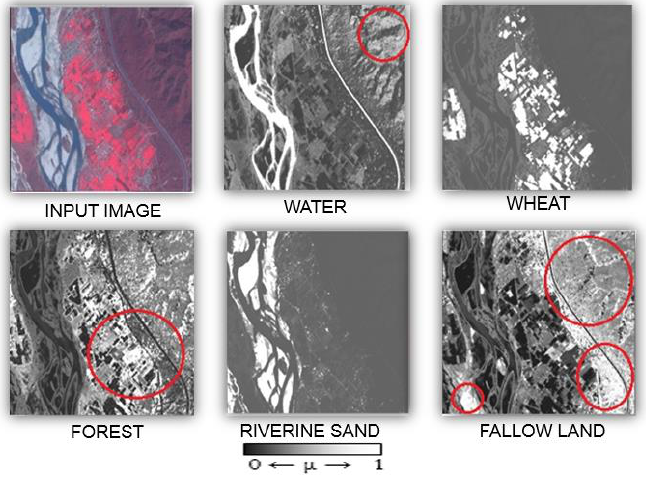
Figure 7. The misclassified outputs in red circles while using composite measure with Euclidean and Cosine measures at m* equal to 2.5 and λ equals to 0.5. Table 5. The comparative results of the best single similarity measures and the composite measure while handling the pure pixel classes and also its behaviour within the class variation (membership value was calculated on 8-bit scale i.e., the target values for a class is 255 and 254 (with a variation of 1 within the class)).